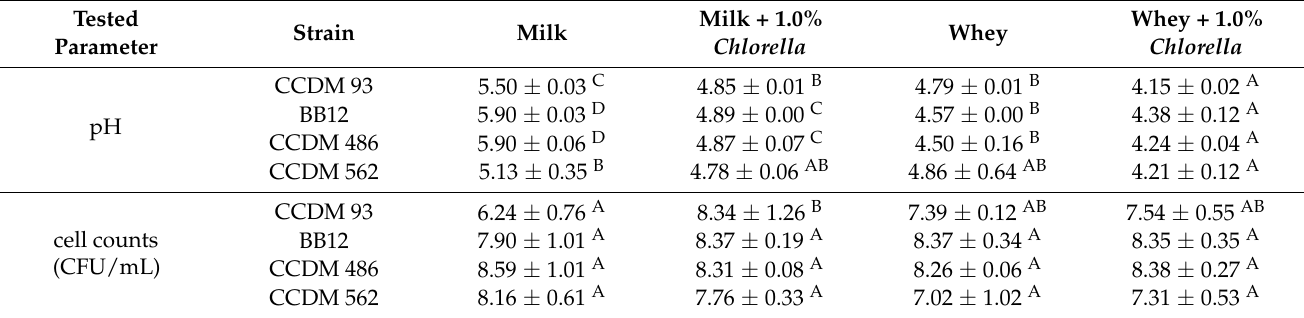
Table 3. pH and cell counts after 24 h cultivation.